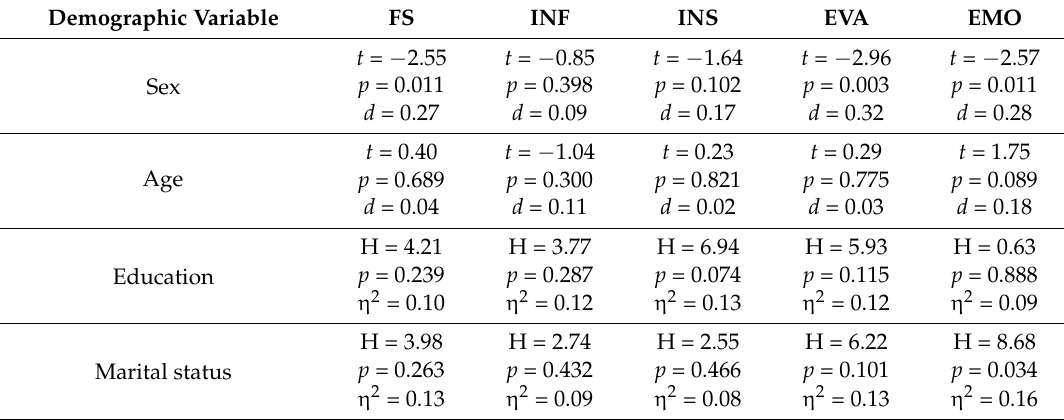
Table 5. Intergroup analysis of functional support in the context of demographic variables. Demographic Variable FS INF INS EVA